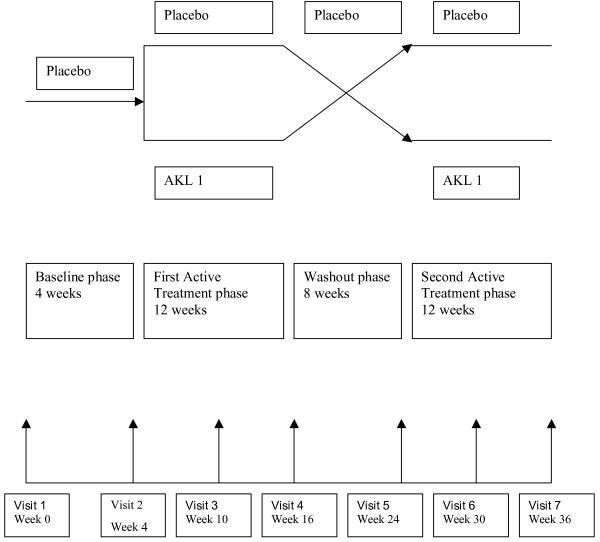
Study Schematic.